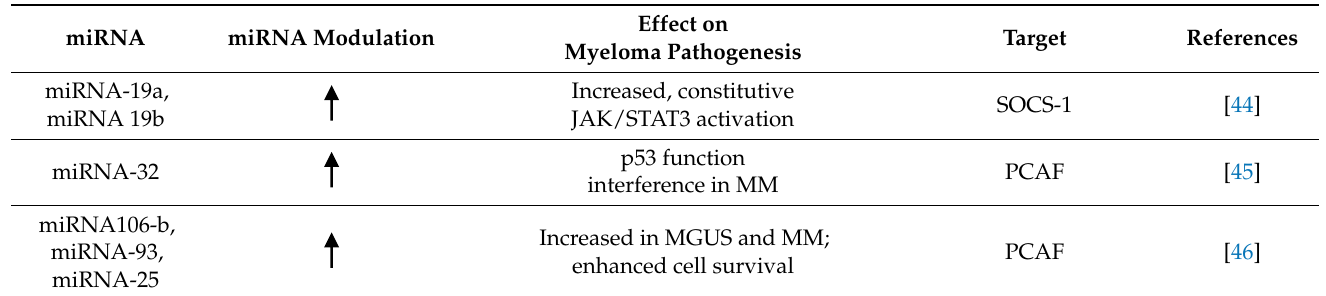
(Table 1). The pathways analysis confirmed the role of miRNAs in oncogenic signaling [36]. Table 1. miRNAs involved in myeloma pathogenesis and their functions. Table 1. Cont.